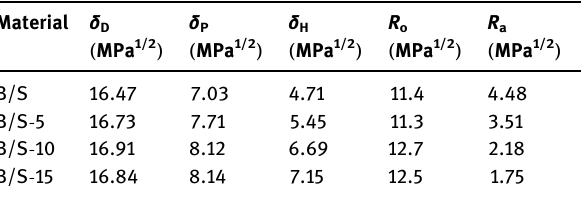
Table 3: Calculated HSP, R o of B/S, B/S - 5, B/S - 10 and B/S - 15, and HSP distance R a between these particles and the neat epoxy